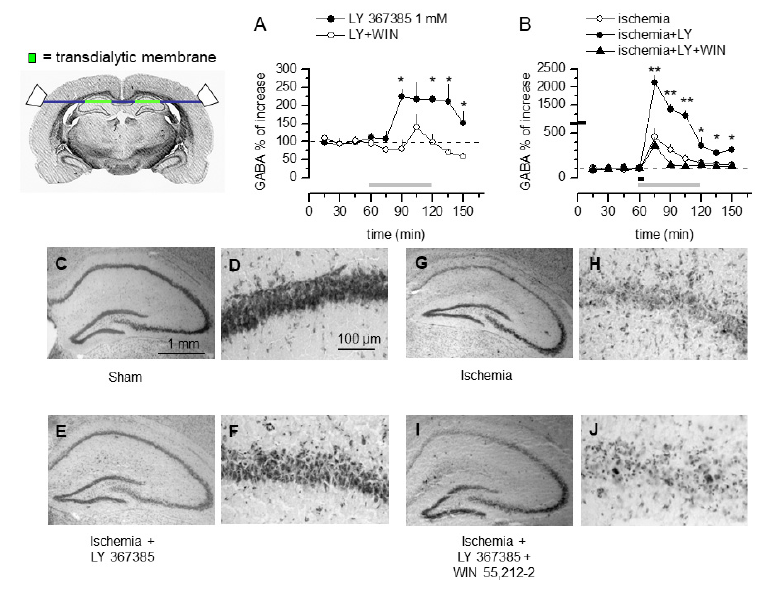
Figure 6. The hippocampal output of GABA and the neuroprotective effects produced by LY 367385 are prevented by WIN 55,212-2 in gerbils subjected to global ischemia. Top left: The position of the transerve microdialysis probe and of the transdialytic membranes is shown. ( A , B ) Time course of the changes in GABA concentrations induced by transmembrane perfusion of LY367385 (1 mM) and LY367385 + WIN 55,212-2 (50 µM) in hippocampal dialysates (gray lines depict time of application) of freely moving gerbils under control conditions ( A ) and after 5 min bilateral carotid occlusion ( B ,